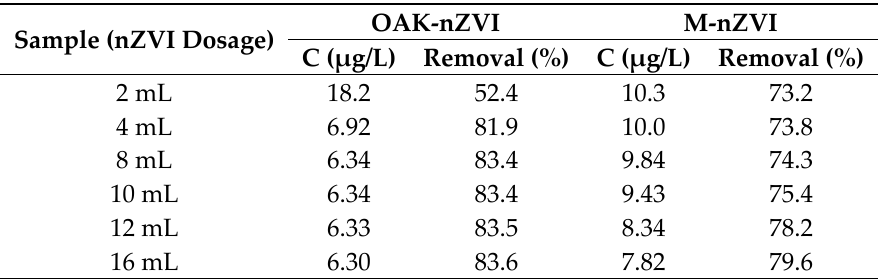
Table 1. As(III) ( 40 µg/L) removal efficiencies when in a mixture with PO 43 − using OAK-nZVI and M-nZVI.